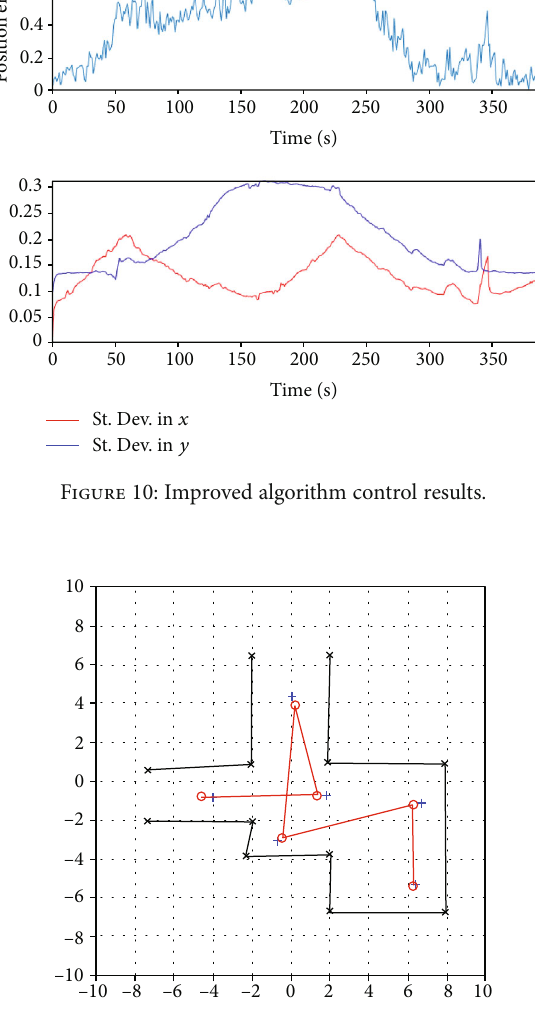
Figure 11: Experiment 2 environment schematics.